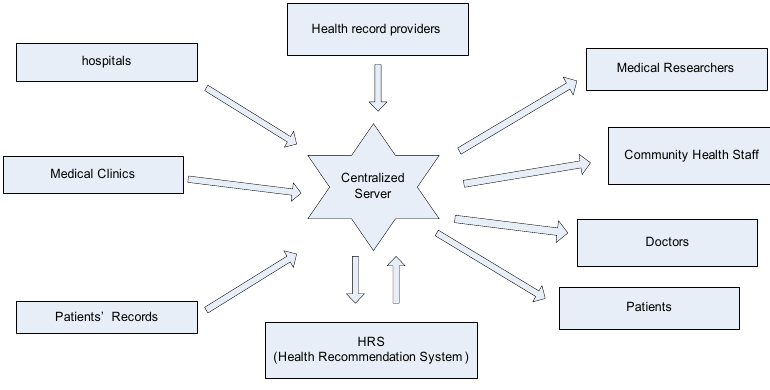
Figure 4. Health Recommender System (HRS) Architecture.